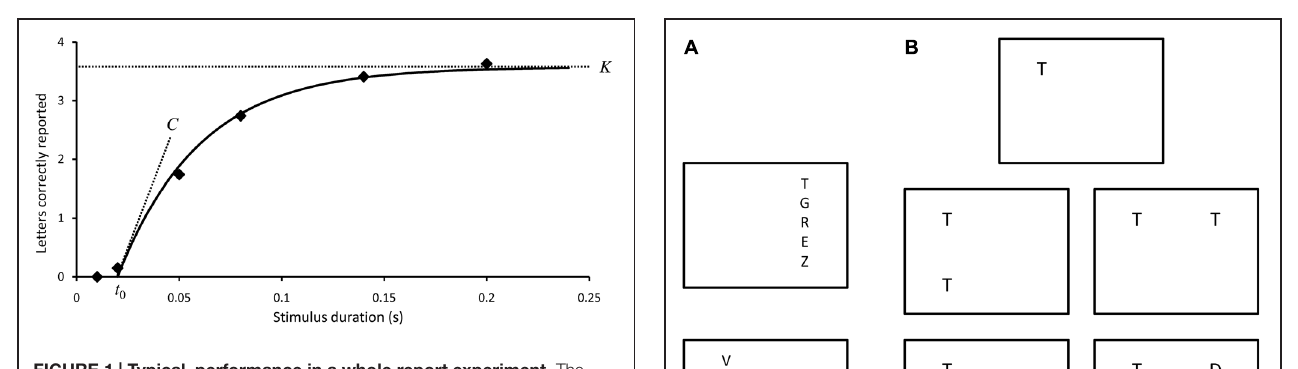
FIGURE 1 | Typical performance in a whole report experiment. The mean number of correct reports (the score) is shown as a function of exposure time. Solid curves represent maximum likelihood fits to the observations based on TVA analysis. The three TVA parameters that can be derived from whole report data are marked out: the perceptual threshold t 0 , the visual processing speed C , and the storage capacity of visual short-term memory K .